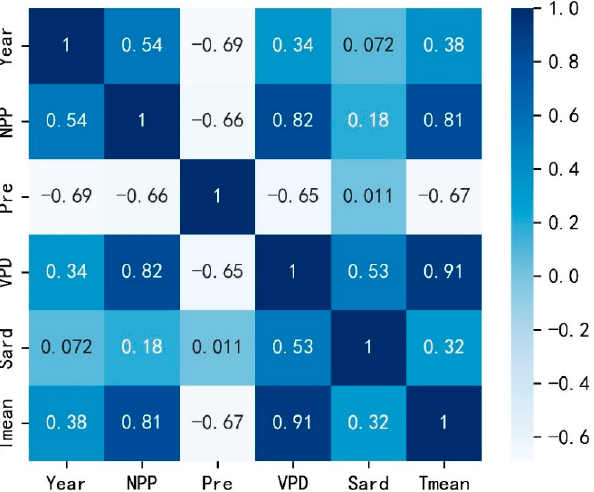
Figure 9. Correlation coefficient (r) matrix of NPP and meteorological data in growing seasons in the Greater Khingan Mountains in Inner Mongolia.